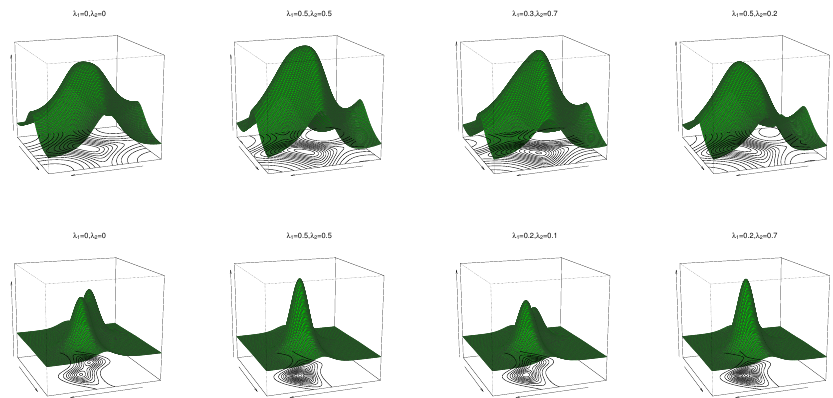
Figure 5. Pdf and contour plots of the sine-skewed transformed cosine model in (22) (top) and the sine-skewed transformed sine model in (24) (bottom) for different values of λ 1 and λ 2 .